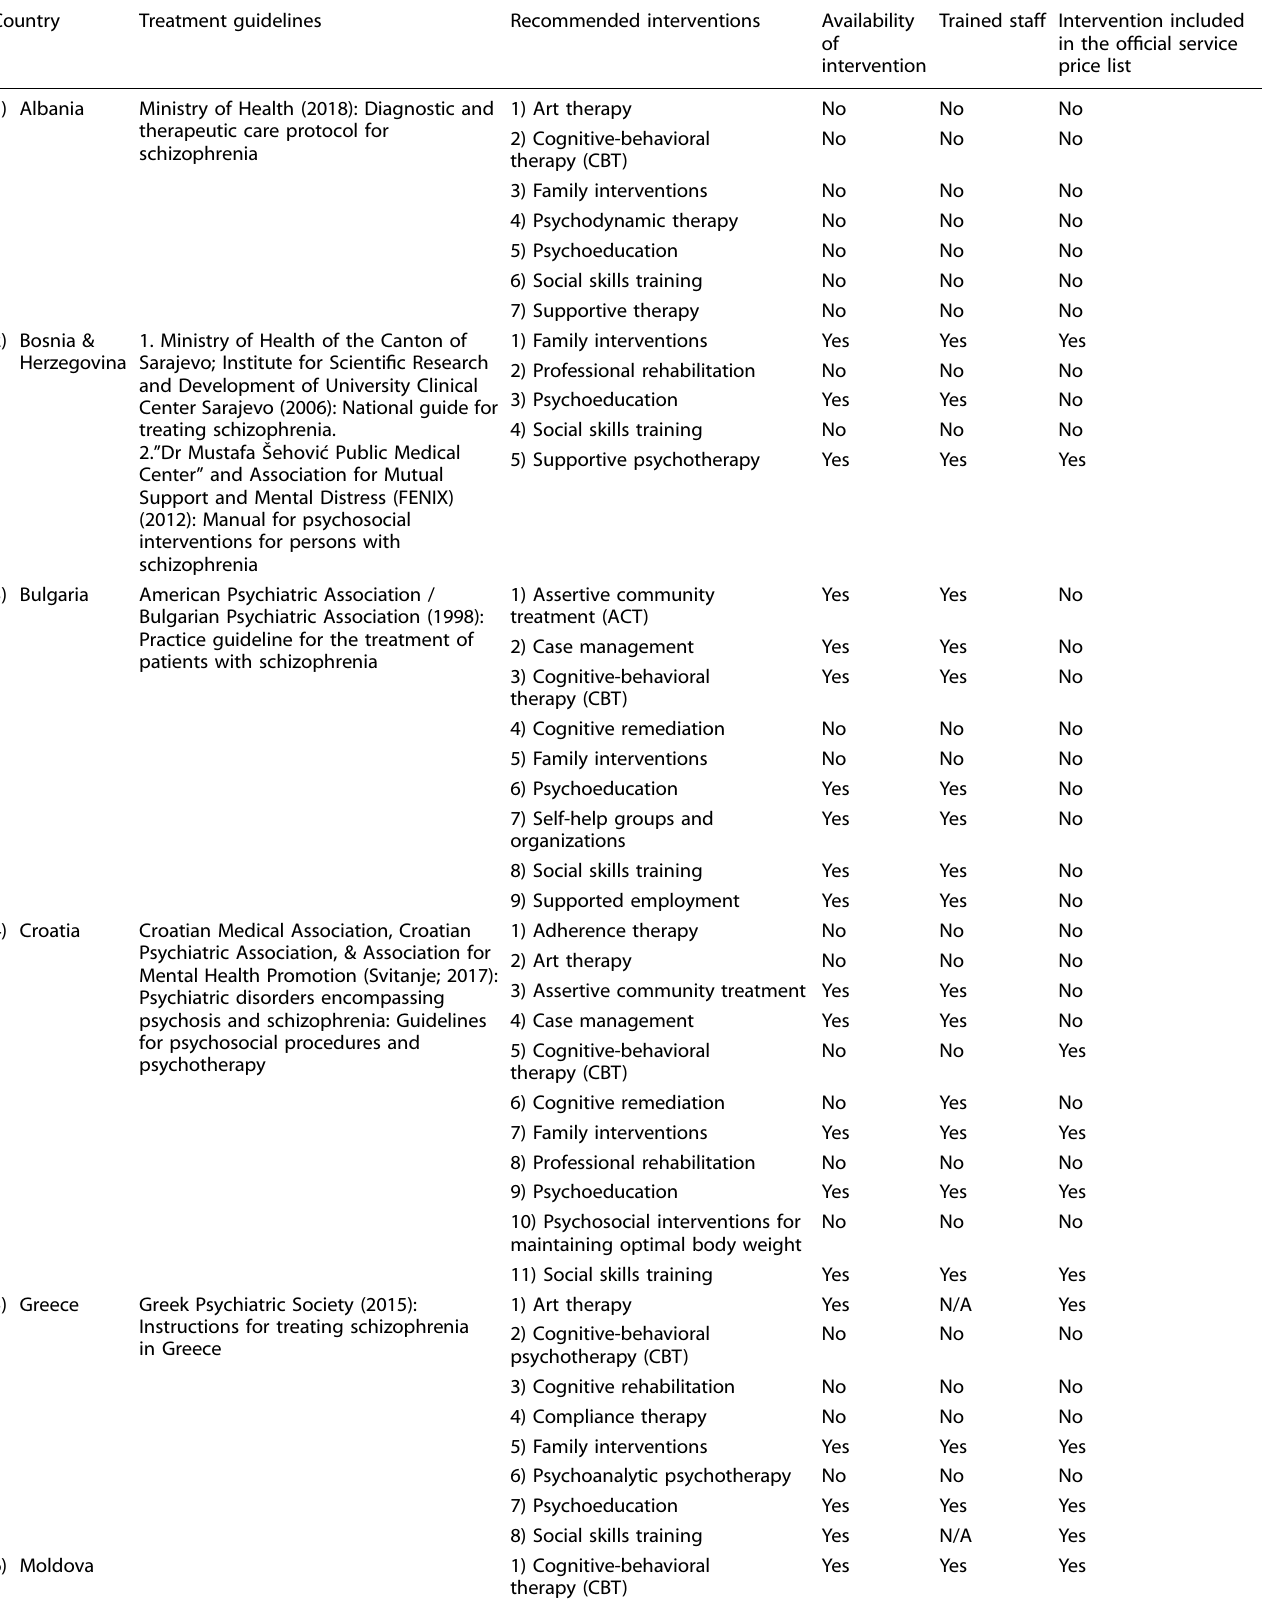
Table 1. SEE countries with published treatment guidelines for non-pharmacological treatment of schizophrenia — recommended interventions and implementation indicators (availability of intervention, training staff, and whether the intervention is included in the of fi cial service price list).